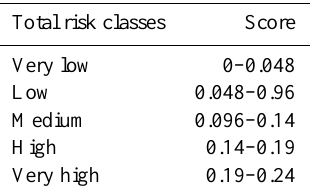
Table 17. Overall risk index classification and range of